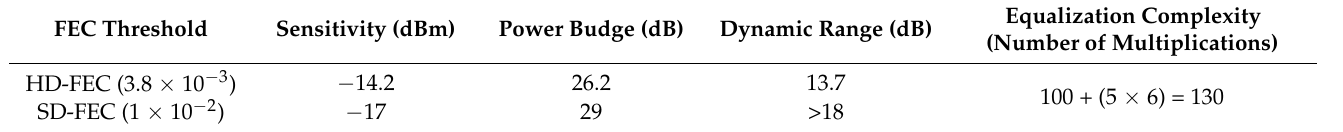
Table 3. 25 km upstream transmission with 2nd-order VNLE ( L 1 = 100 and L 2 =